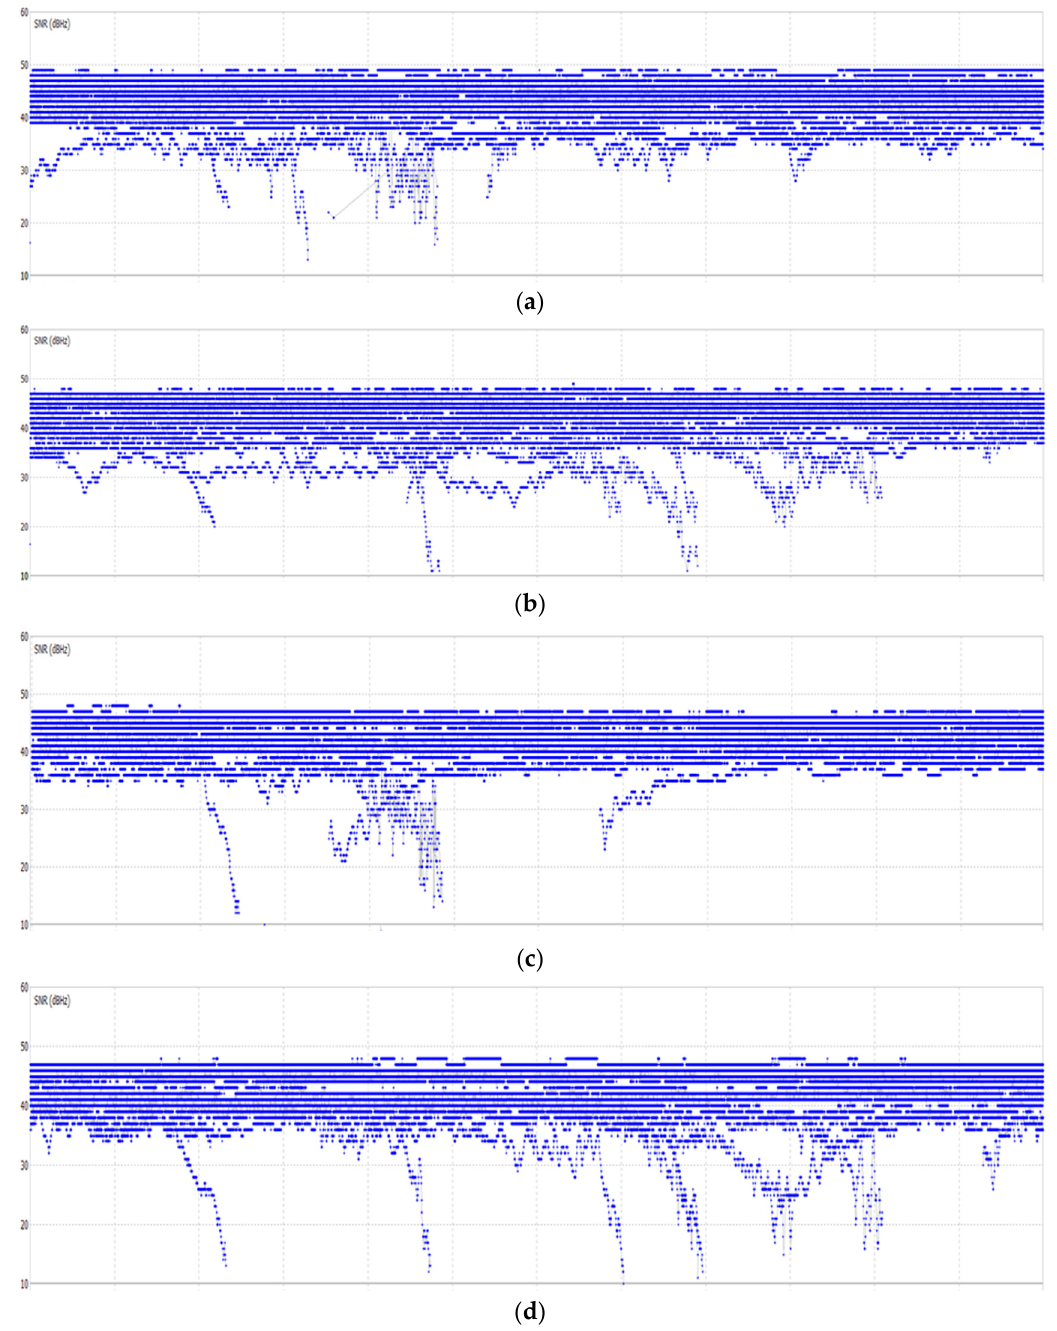
Figure 12. For the G > S > P Sys: ( a ) Best SNR for L1; ( b ) worst SNR for L1; ( c ) best SNR for L2; ( d ) worst SNR for